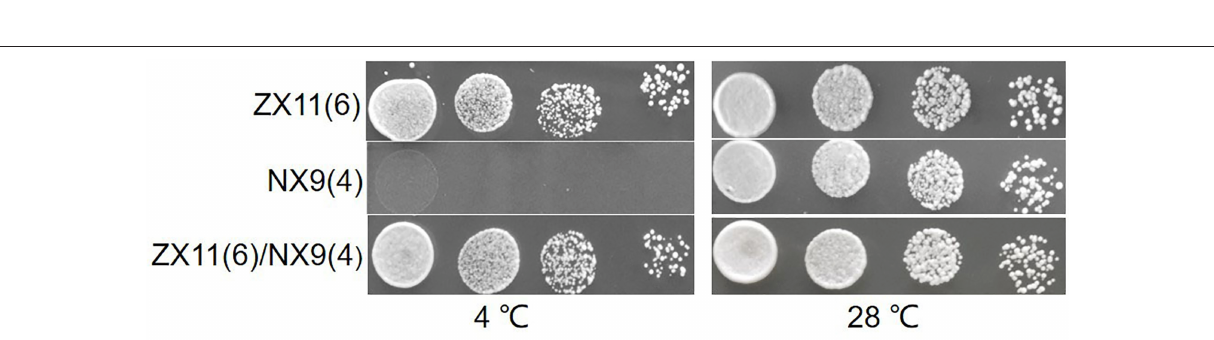
FIGURE 3 | Spot growth at near-freezing temperature of the two parent strains and F1 hybrid. The growth on plates at 4 and 28 ◦ C of ZX11(6), NX9(4), and ZX11(6)/NX9(4) were shown. The haploid strain ZX11(6) showed excellent growth at 4 ◦ C compared to the strain NX9(4). The hybrid diploid strain ZX11(6)/NX9(4) grew nearly as well as its superior parent strain ZX11(6) at 4 ◦ C, indicating that the major causative allele(s) in ZX11(6) is (are) dominant.